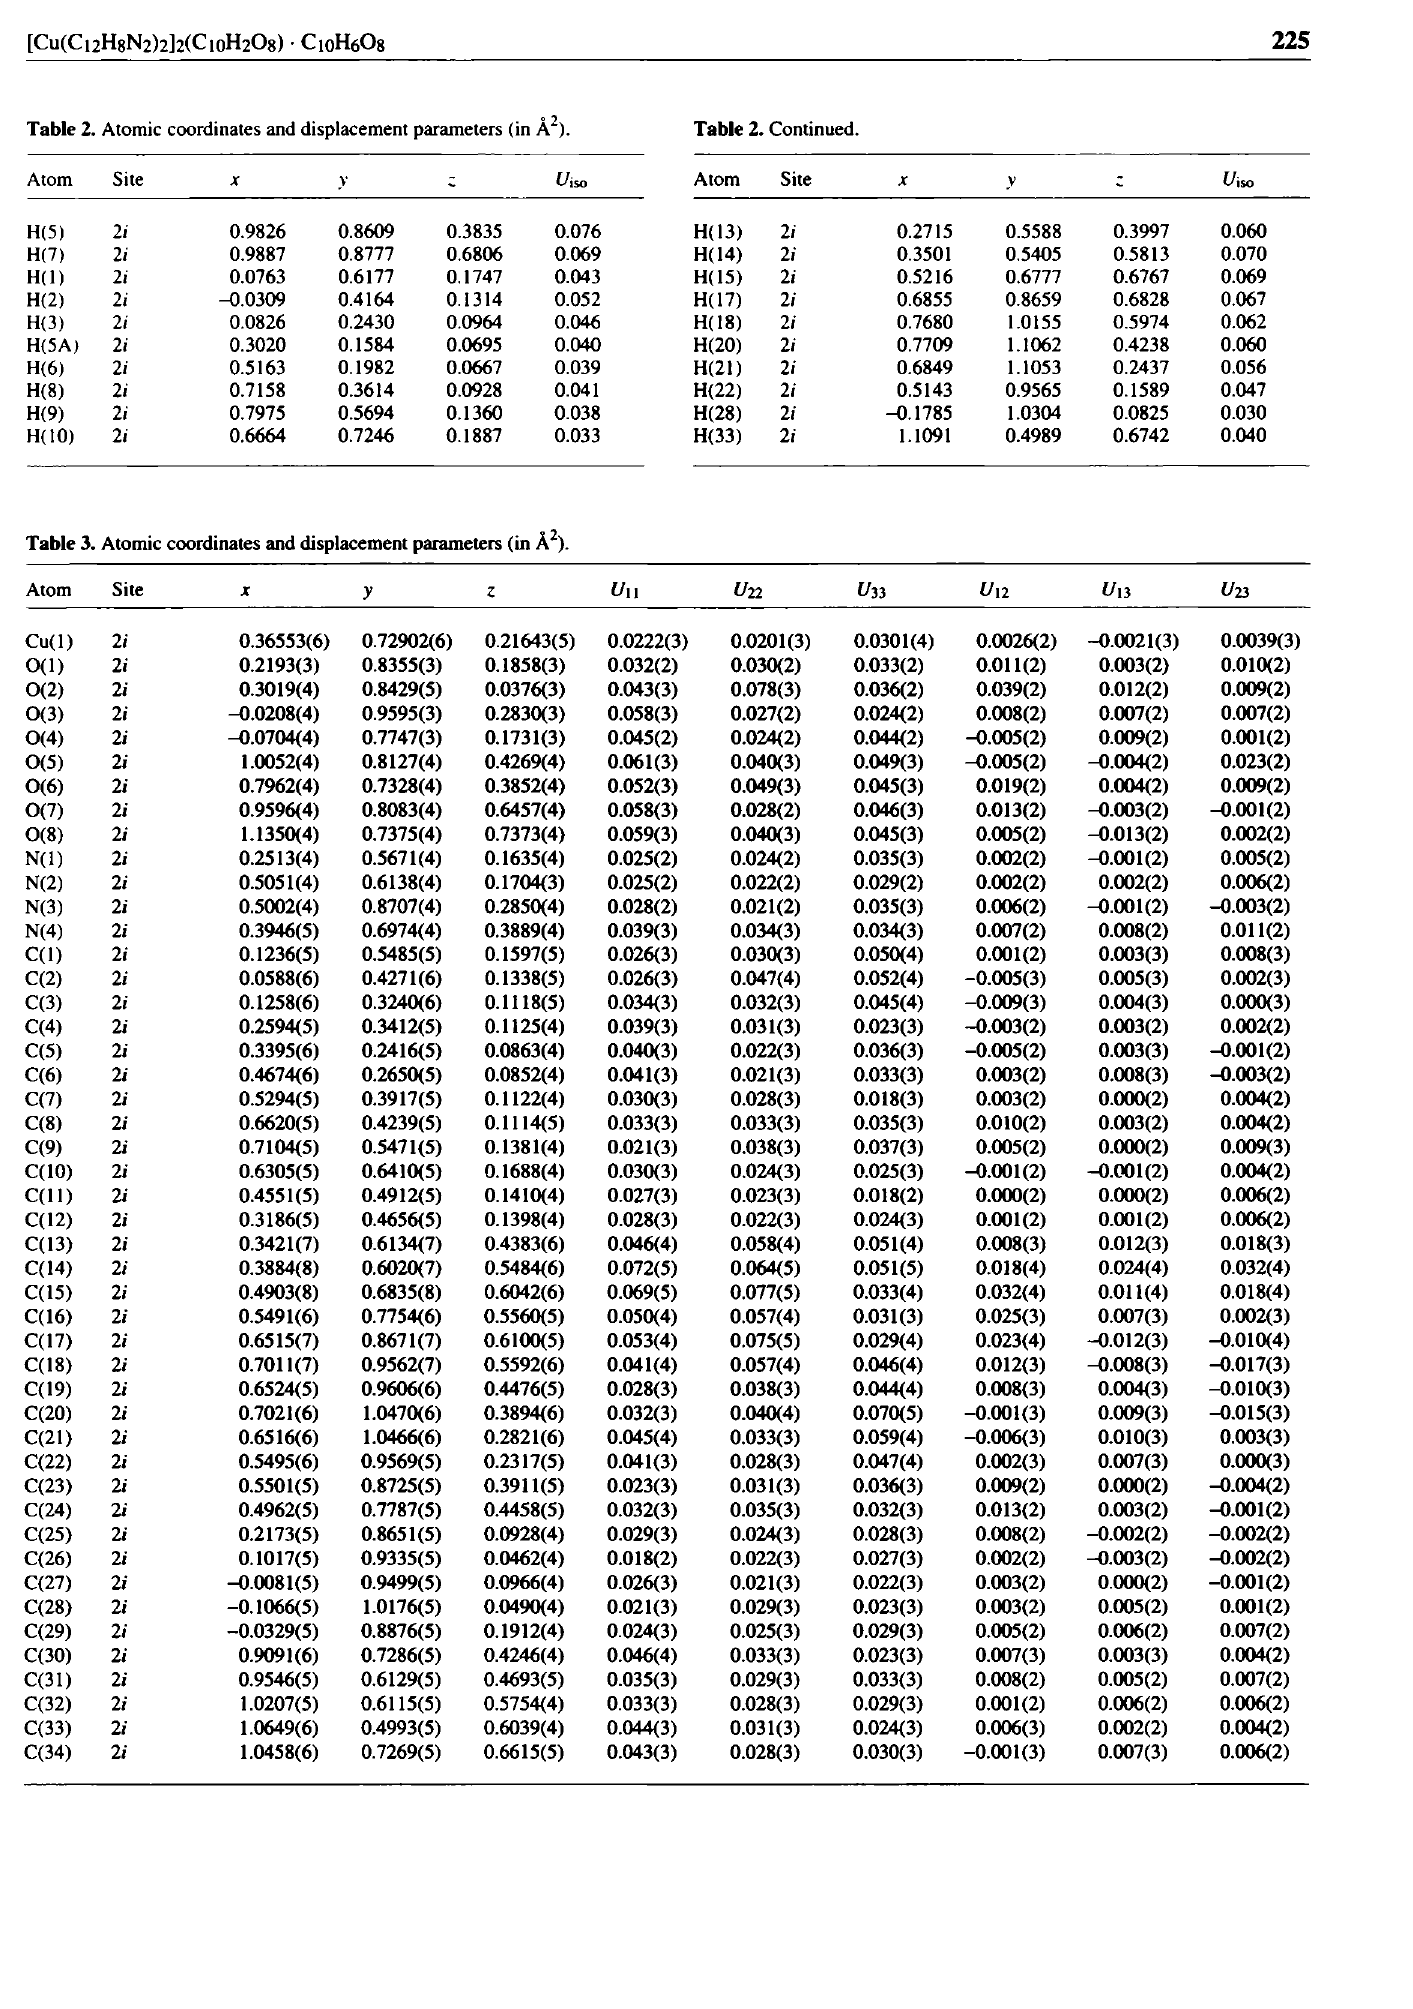
Table 2. Atomic coordinates and displacement parameters (in A 2 ).